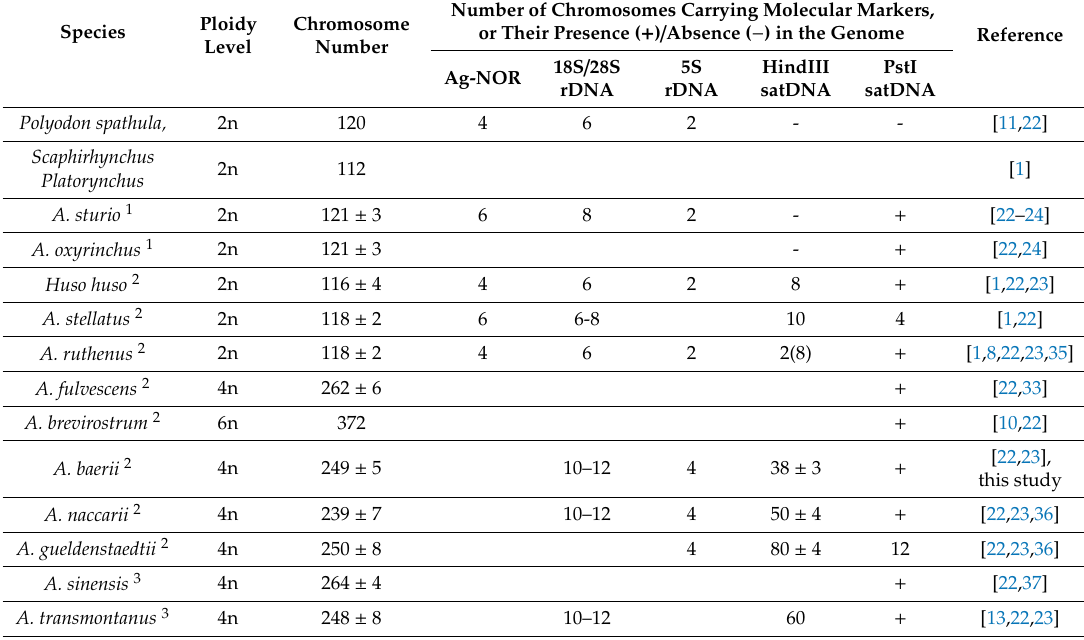
Table 1. Molecular and cytogenetic characteristics of Acipenseriformes